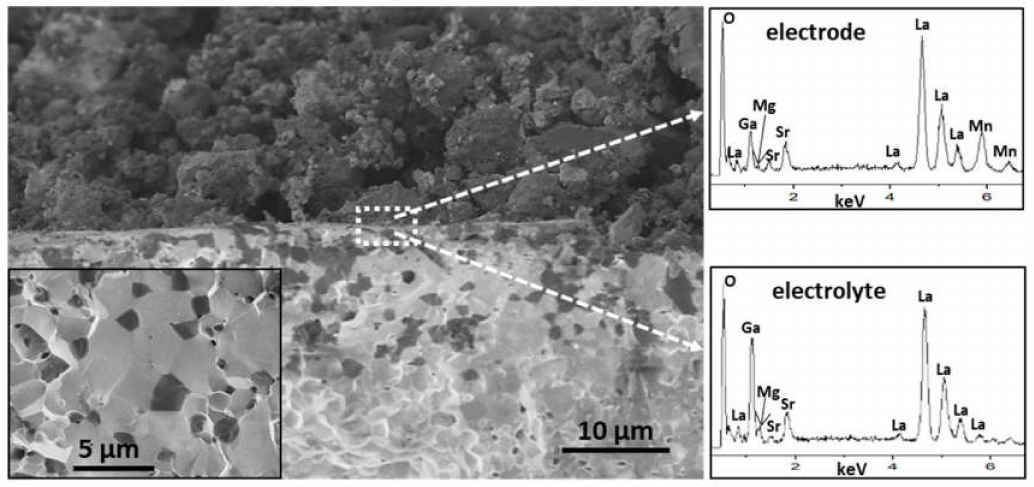
Figure 5. SEM micrograph of the electrode / electrolyte interface cross-section. The inset corresponds to the fracture surface of the electrolyte, from which particle size can be extracted. EDX analyses were taken exactly at the interface from the electrode and electrolyte side,